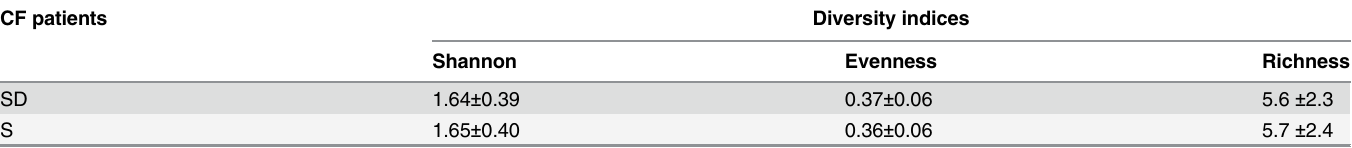
Table 4. Diversity estimates for cultured bacterial communities in sputum samples of CF patients.